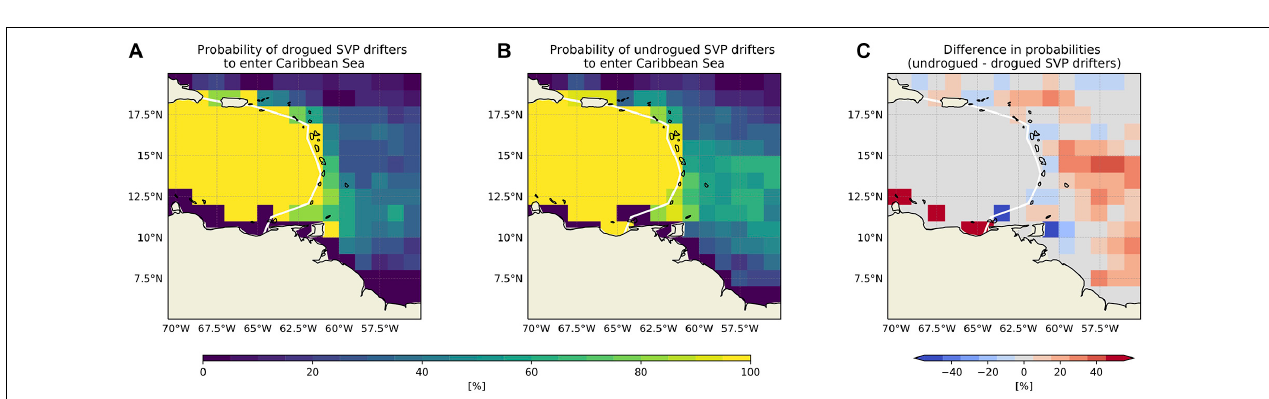
FIGURE 2 | Map of the trajectories of the 20 undrogued Stokes drifters and 18 drogued SVP drifters deployed during the RV Pelagia PE-455 in July and August 2019 and their trajectories are shown through April 2020. Black triangles indicate the release locations in the Tropical Atlantic Ocean, see Supplementary Figure 1 for their labeling. The three red squares indicate locations where beached Stokes drifters were found and reported.